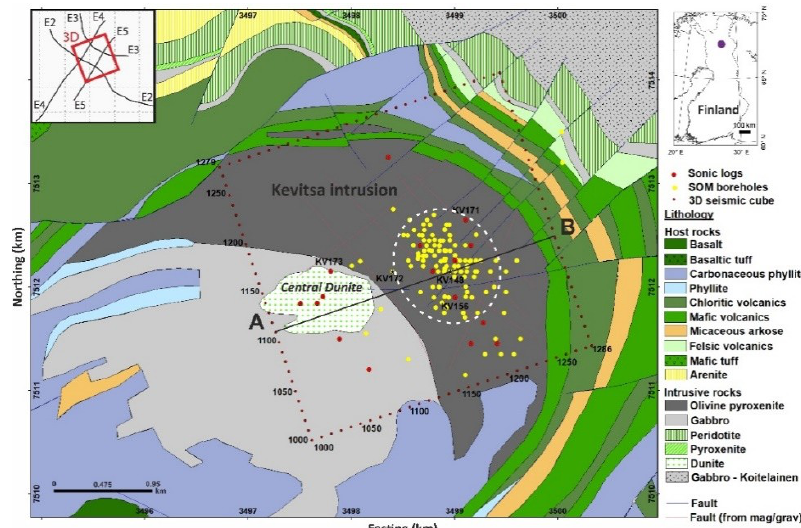
Figure 1. Geological map of the Kevitsa complex showing selected boreholes for the self-organizing map (SOM) analyses (boreholes containing sonic data denoted with red dots). The area of the 3D seismic data is shown with red dotted square. The index map on top left shows the location of the 2D seismic lines in relation to the 3D survey area. The white dashed area represents the approximate location of the open pit mine (and resource area). The location of 3D seismic crossline 1110 ( A – B ) from Figure 2 is shown and the location of boreholes KV171, KV173, KV156, KV172, and KV148. Bedrock geology has been modified from a map provided by [15].